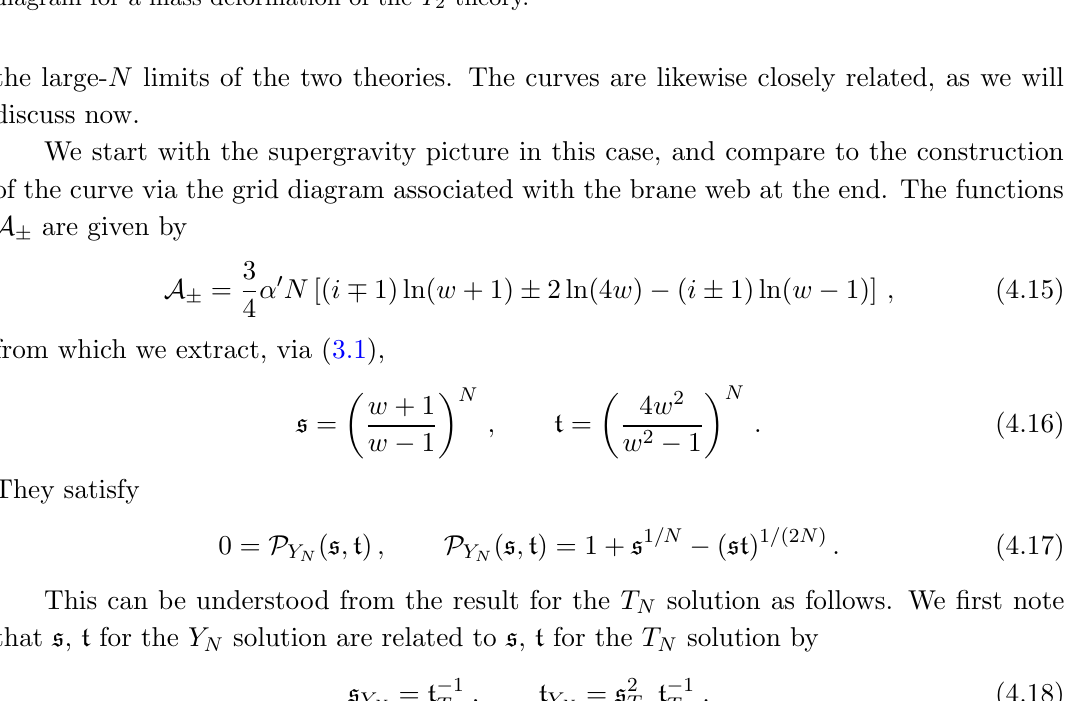
Figure 3. Left: the 5-brane junction describing the Y N SCFTs. Right: brane web and grid diagram for a mass deformation of the Y 2